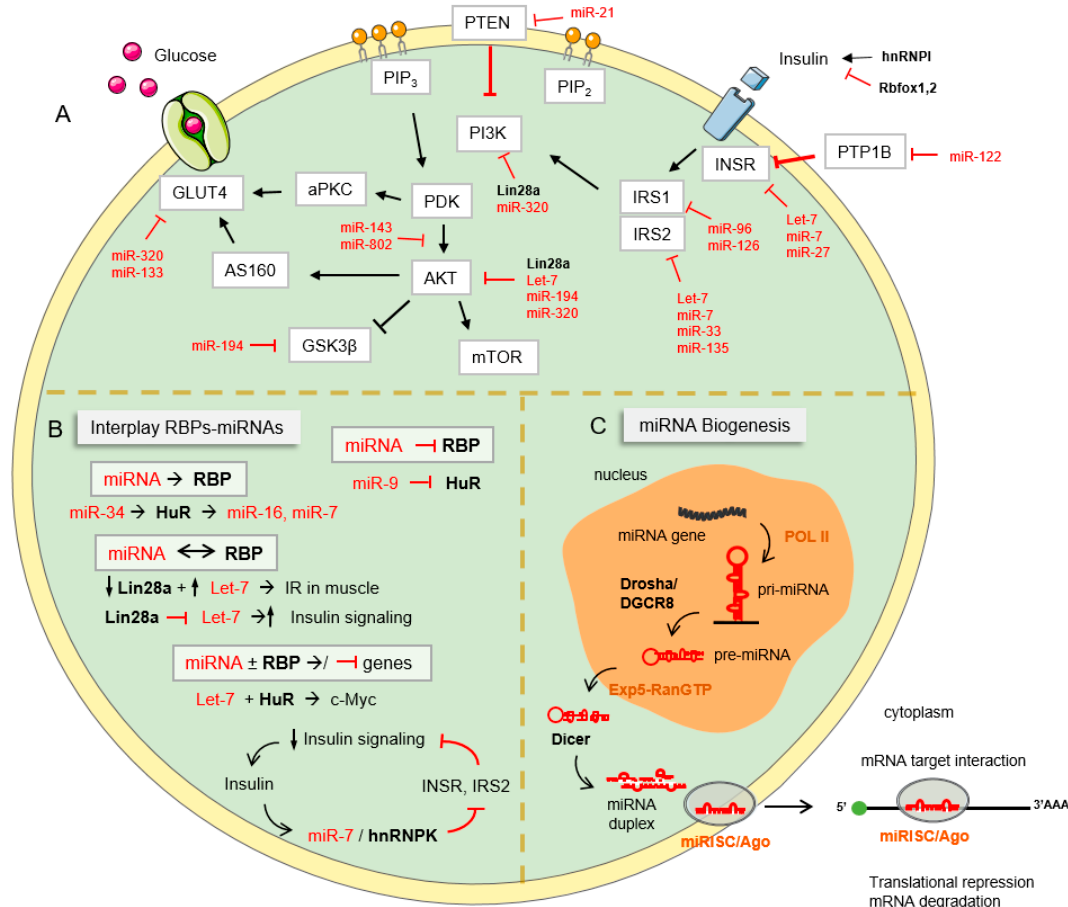
Figure 1. miRNA and RBP regulation of insulin signaling in metabolic diseases. ( A ) Schematic overview of miRNAs and RBPs involved in the regulation of the insulin signaling pathway. ( B ) Coop- eration between RBPs and miRNAs. ( C ) General view of microRNA biogenesis. RBPs are represented in bold and miRNAs are represented in red. Black arrows represent activation processes and red lines represent inhibition processes. Note that the target genes showed in the figure are those validated experimentally, but these genes can be also modulated by other miRNAs and the miRNAs highlighted can regulate other genes that do not appear in the